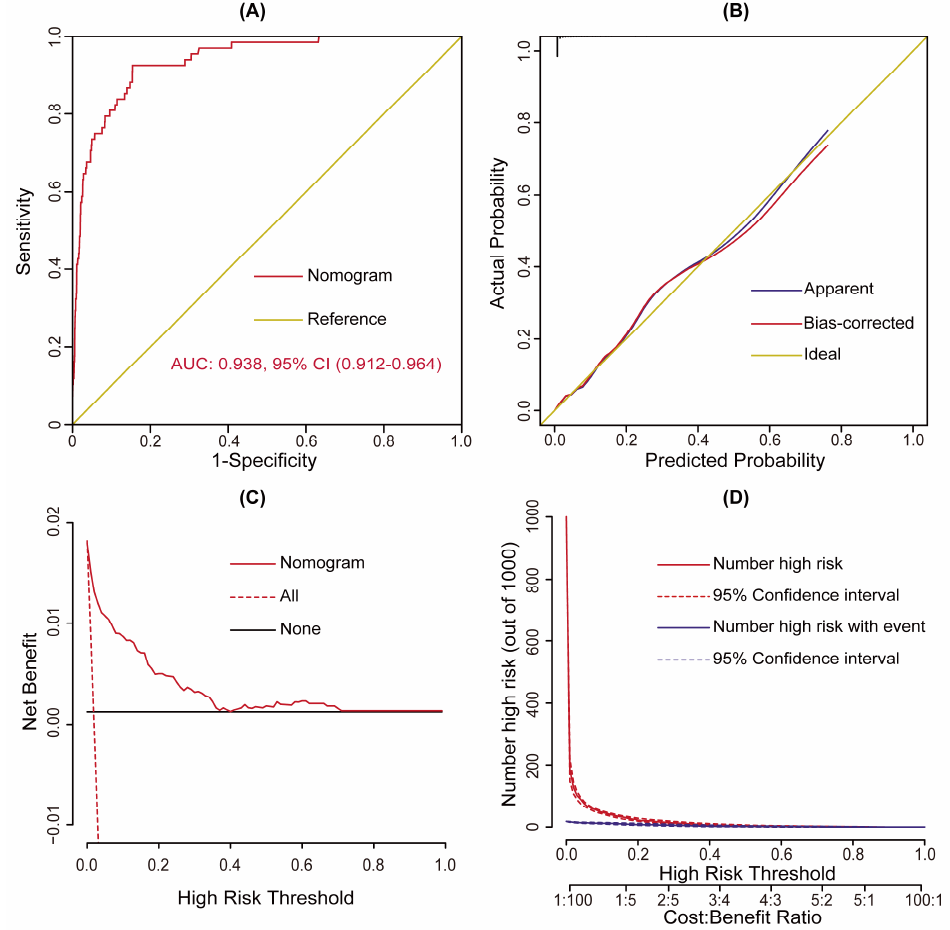
Figure 3. Assessment of the risk prediction model for postoperative tracheostomy after heart valve surgery. ( A ) ROC curve and the corresponding AUC, ( B ) calibration curves, ( C ) decision curve, and ( D ) clinical impact curve of the model. AUC, area under the receiver operating characteristic curve; CI, confidence interval; ROC, receiver operating characteristic curve.